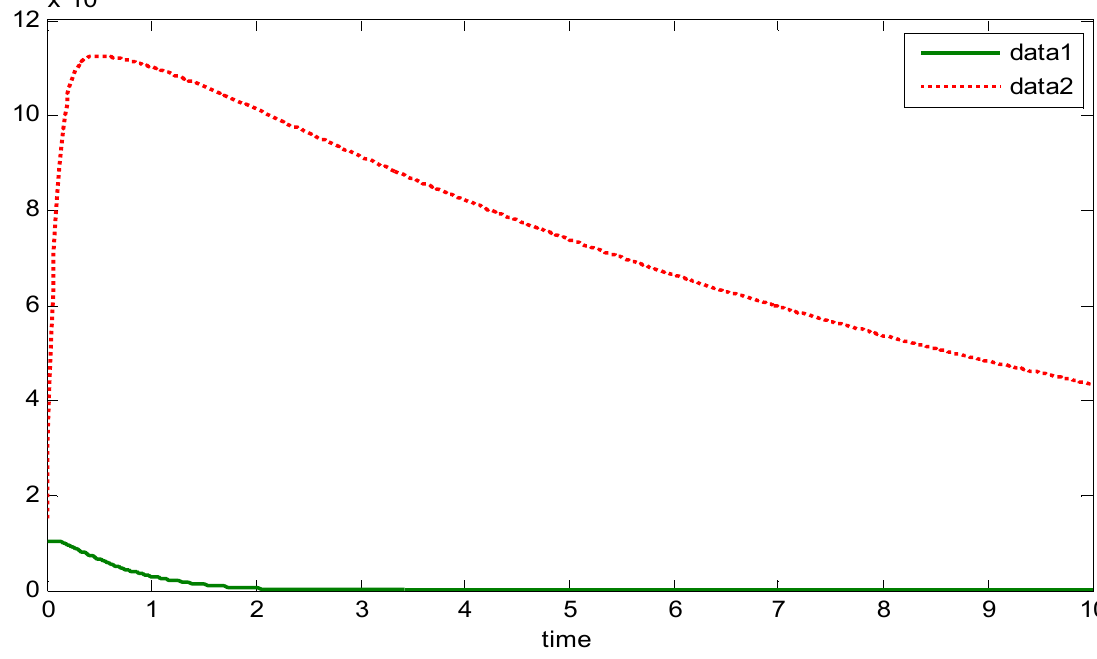
Figure 5. Comparing the susceptible vaccinated population with the exposed population.